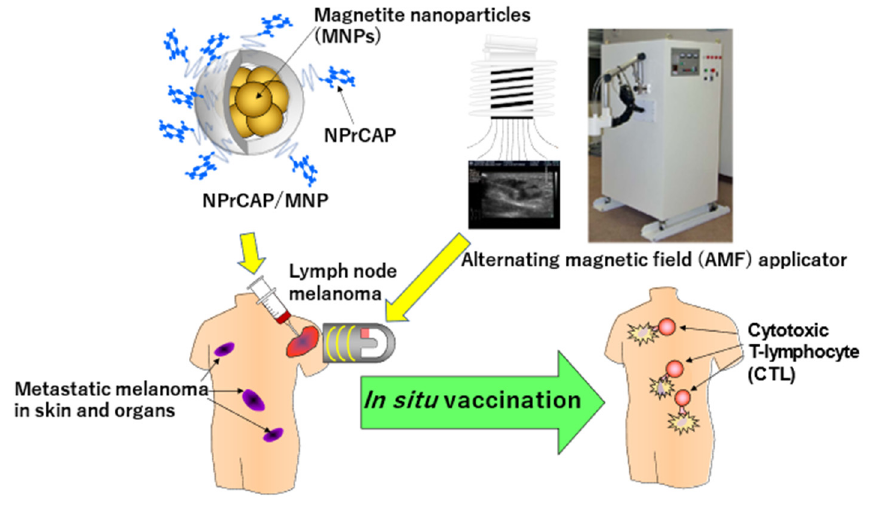
Figure 19. Flow of CTI therapy using conjugates of NPrCAP and MNP with exposure to alternating magnetic field (AMF) and growth inhibition of metastatic melanoma lesions by immunomodulated in situ vaccination.